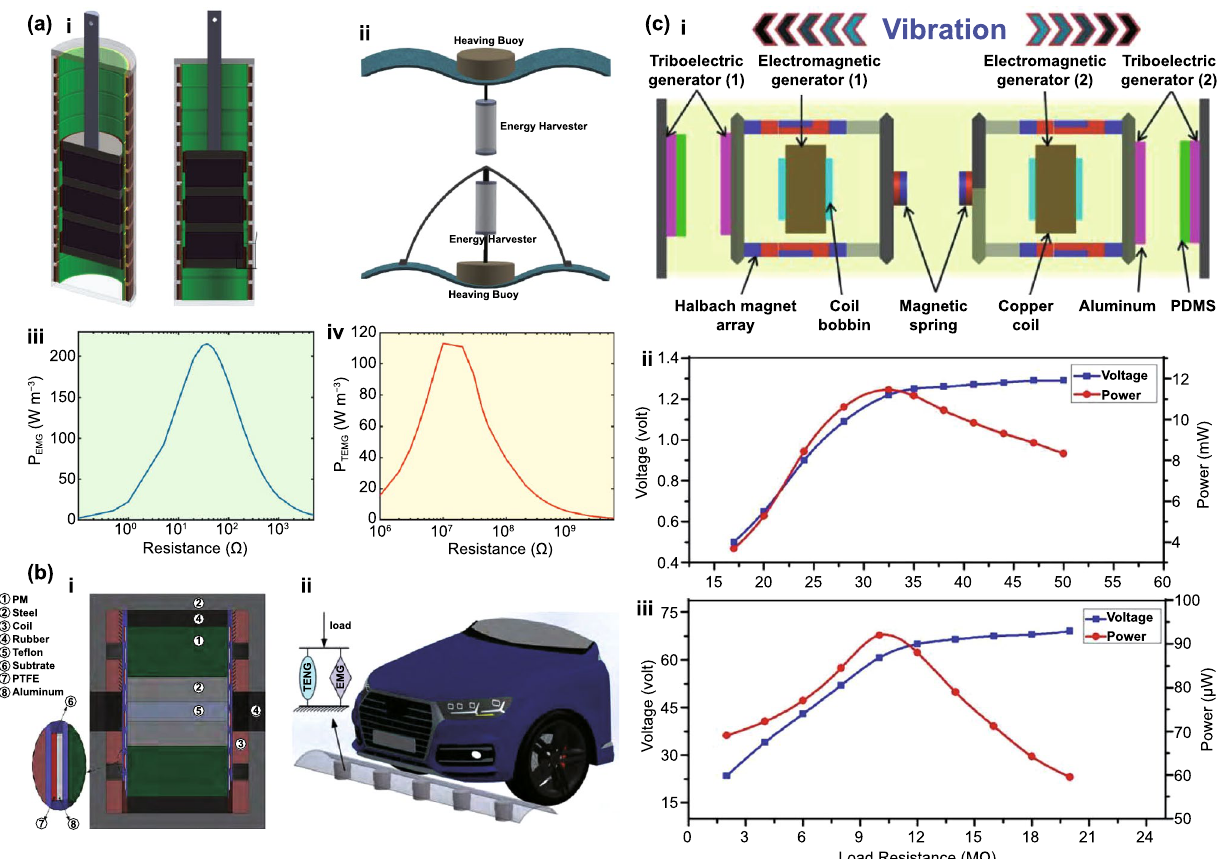
Fig. 17 a (i) Heaving point absorber-based E-TENG wave energy harvester modeled by Saadatnia et al. (ii) Schematic model of the energy har- vester integrated with an heaving buoy under water wave excitations. Calculated output power density as a function of the load resistance for the (iii) EMG and (iv) TENG. Adapted from Ref. [80, 81]. b (i) Cross section view of the hybrid generator proposed by Askari et al. (ii) Car passing over a speed bumper equipped by a hybridized nano generator. Reproduced with permission from Ref. [82]. Copyright 2016, Published by Else- vier Ltd. c (i) Schematic structure of the Halbach array-based hybrid energy harvester proposed by Salauddin et al. Load voltages (peak to peak) and powers (peak) versus load resistances generated by the (ii) EMG and (iii) TENG. Reproduced with permission from Ref. [83].